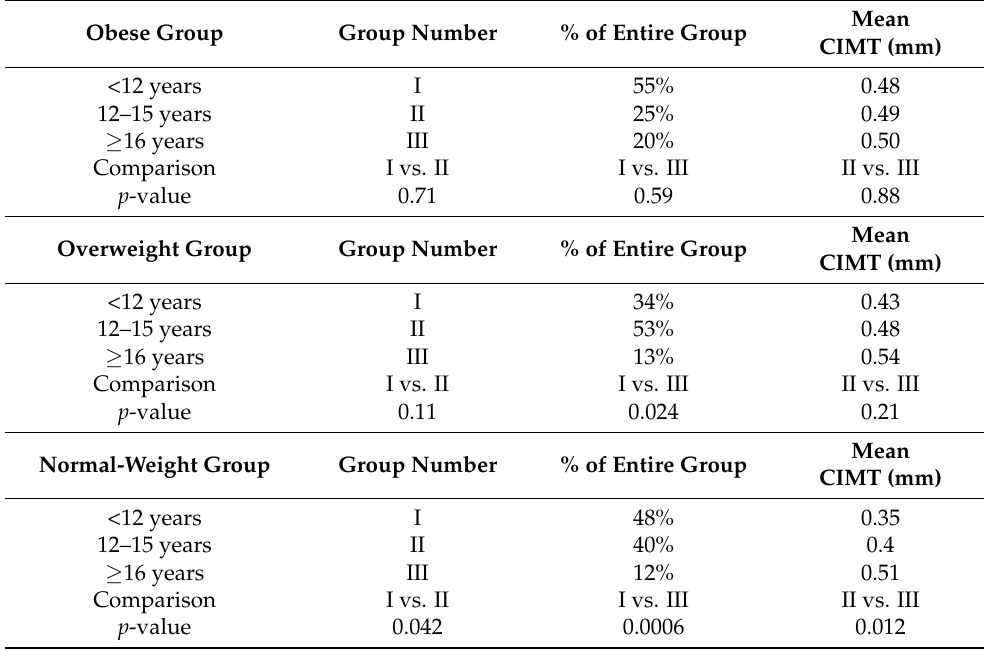
Table 1. CIMT differences with regard to age.